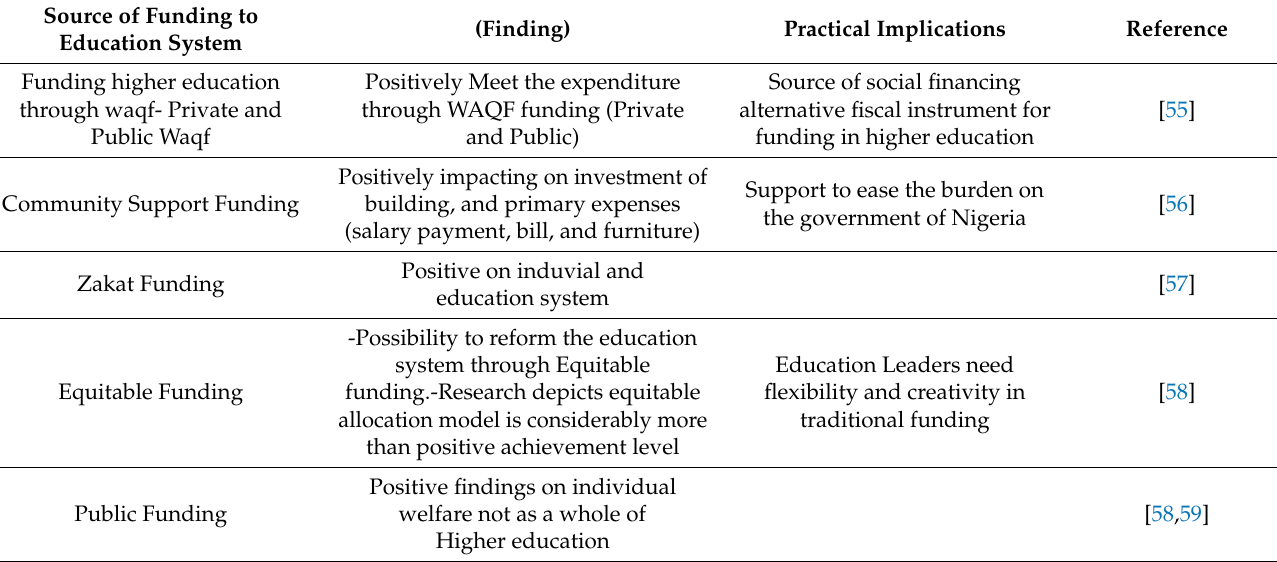
Table 2. Literature Review in funding sources to the education